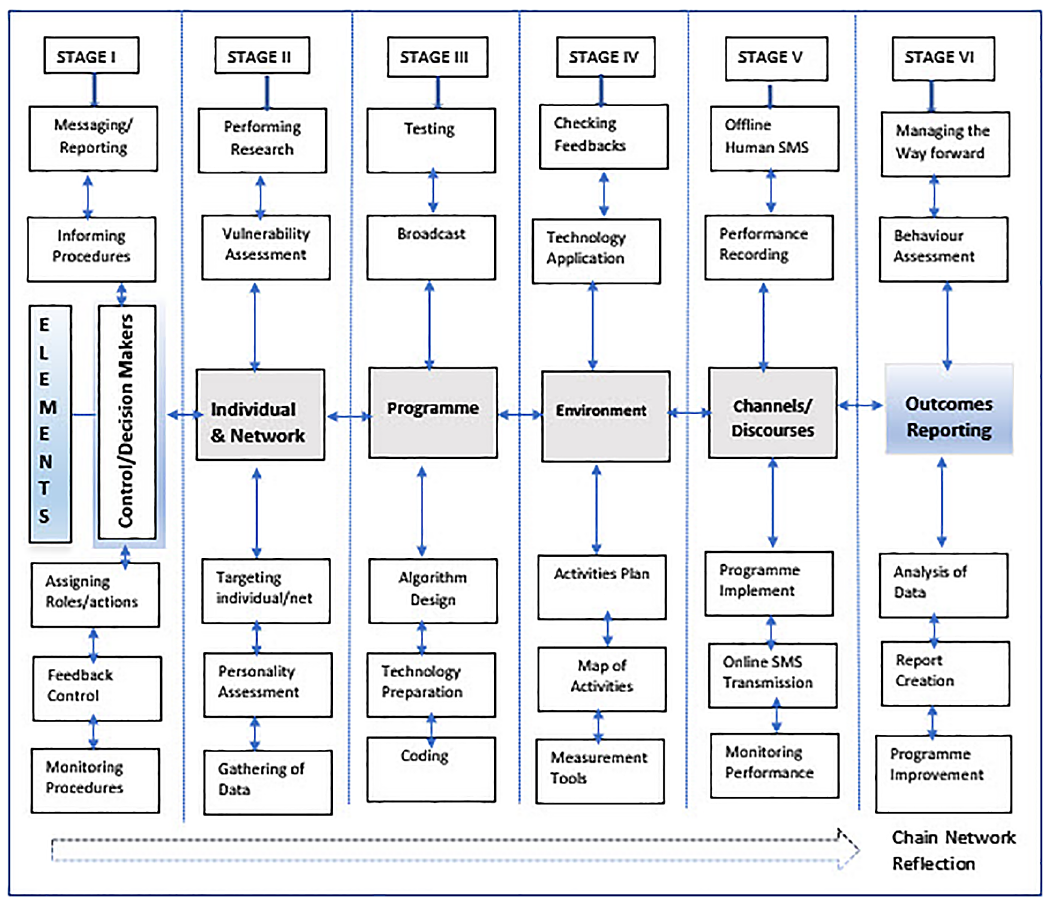
Figure 1. The MCC model of coercive